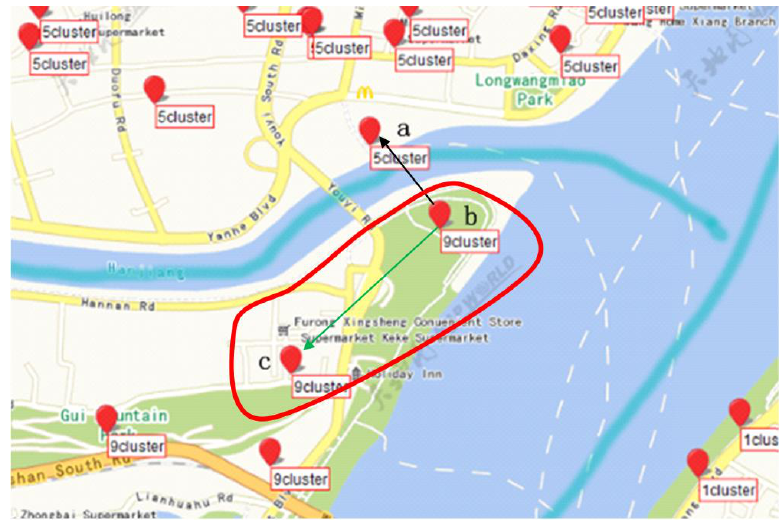
Figure 15. Snapshot of a portion of the results obtained for the clustering analysis with constraints (at a zoomed-in scale). There is no figure reused directly from other publication.